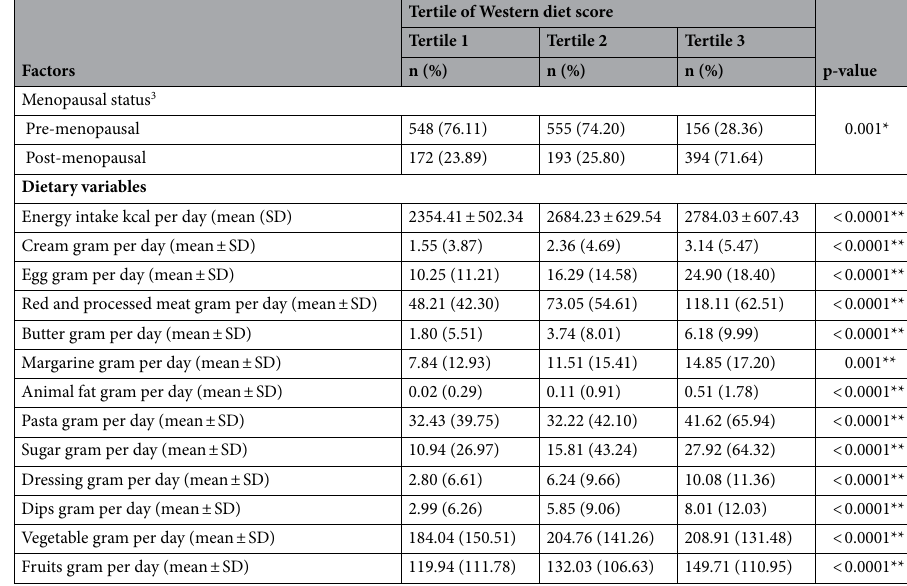
Table 2. General characteristics, and dietary information based on tertiles of adherence to the Western dietary pattern. IDC invasive ductal carcinoma, ILC invasive lobular carcinoma, BC breast cancer; SD standard deviation, OCP oral contraceptive pills, BMI body mass index. p values are based on *the Chi-squared test or **one-way ANOVA test. 1 First or both first and second relatives. 2 Based on WHO definition: 30 min or more of moderate aerobic activity at least 3 or more times/week on a regular basis. 3 Only natural menopause.